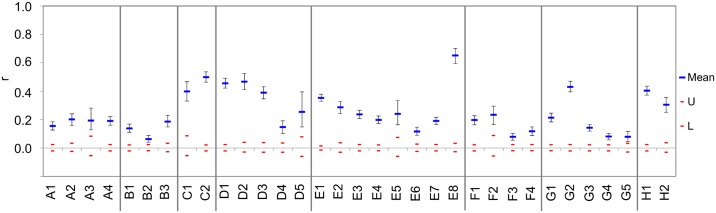
Correlogram representing the mean within-population pairwise similarities using the Lynch & Ritland (1999) estimator.Upper (U) and lower (L) confidence limits bound the 95% CI of the null hypothesis of 'No Difference' across the populations using 999 random permutations, and for estimates of r by bootstrapping 1,000 pairwise comparisons. Whiskers represent the highest and lowest values within a dataset for each distance class. Regions are separated by vertical grey lines. Codes of sites correspond to those of Table 1.